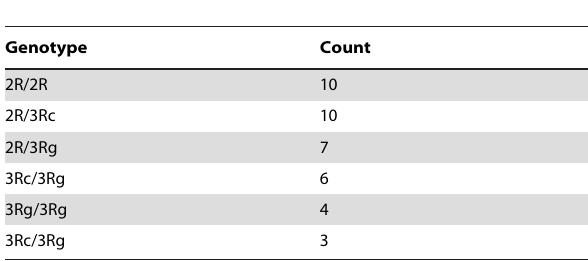
Table 1. VNTR genotypes among 40